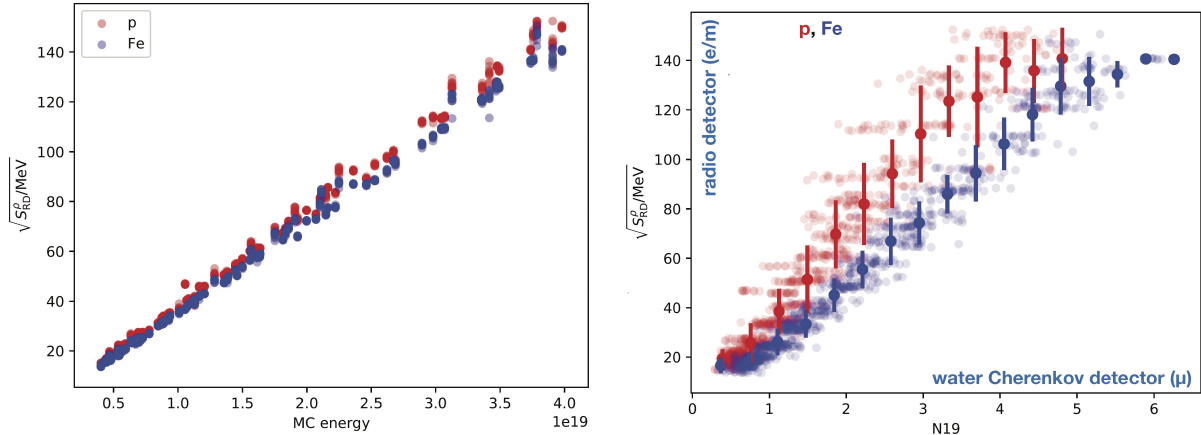
Figure 8. Estimated performance of the Radio Detector. P reliminary results ; The radio detector resolution is not yet included. Left: radiation energy (i.e. the electromagnetic energy of the shower) as a function of the shower energy. Right: electromagnetic energy in a shower as measured by the Radio Detector as a function of the muon content in a shower as measured by the water-Cherenkov